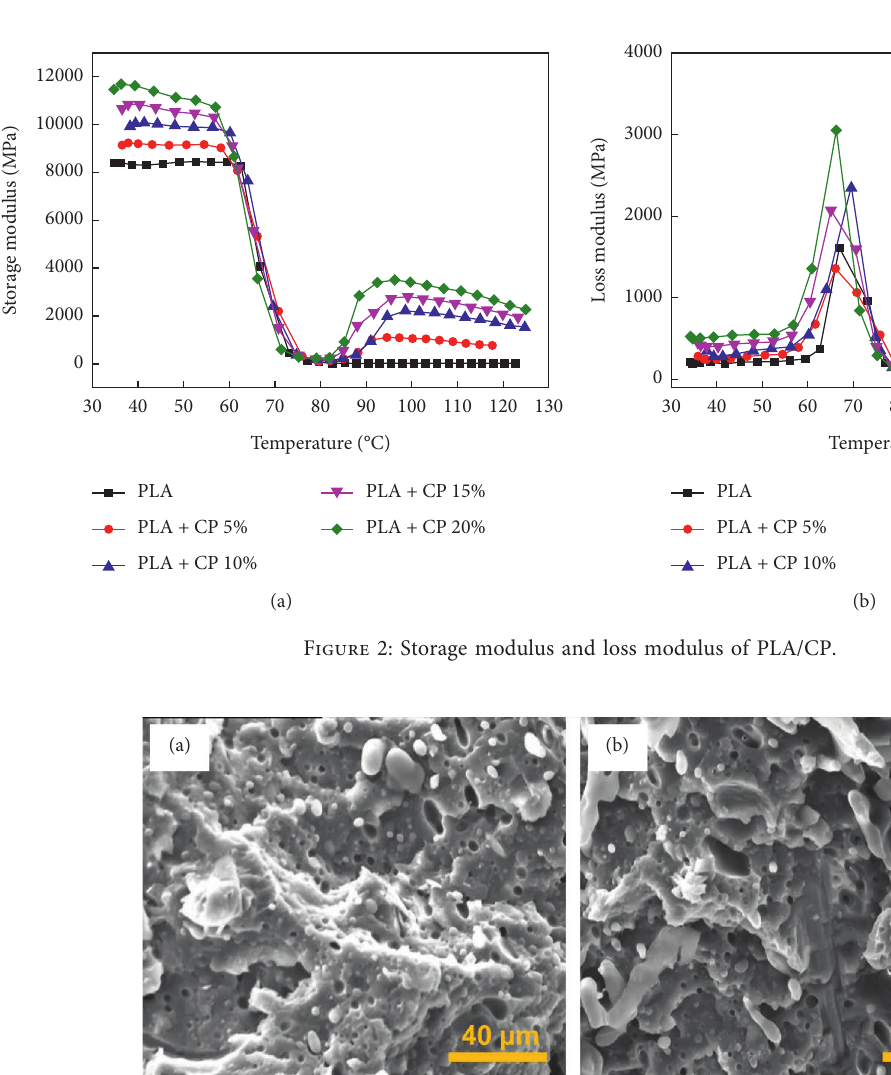
Figure 3: SEM image showing interaction of CP with PLA: (a) 15% CP composite and (b) 20% CP